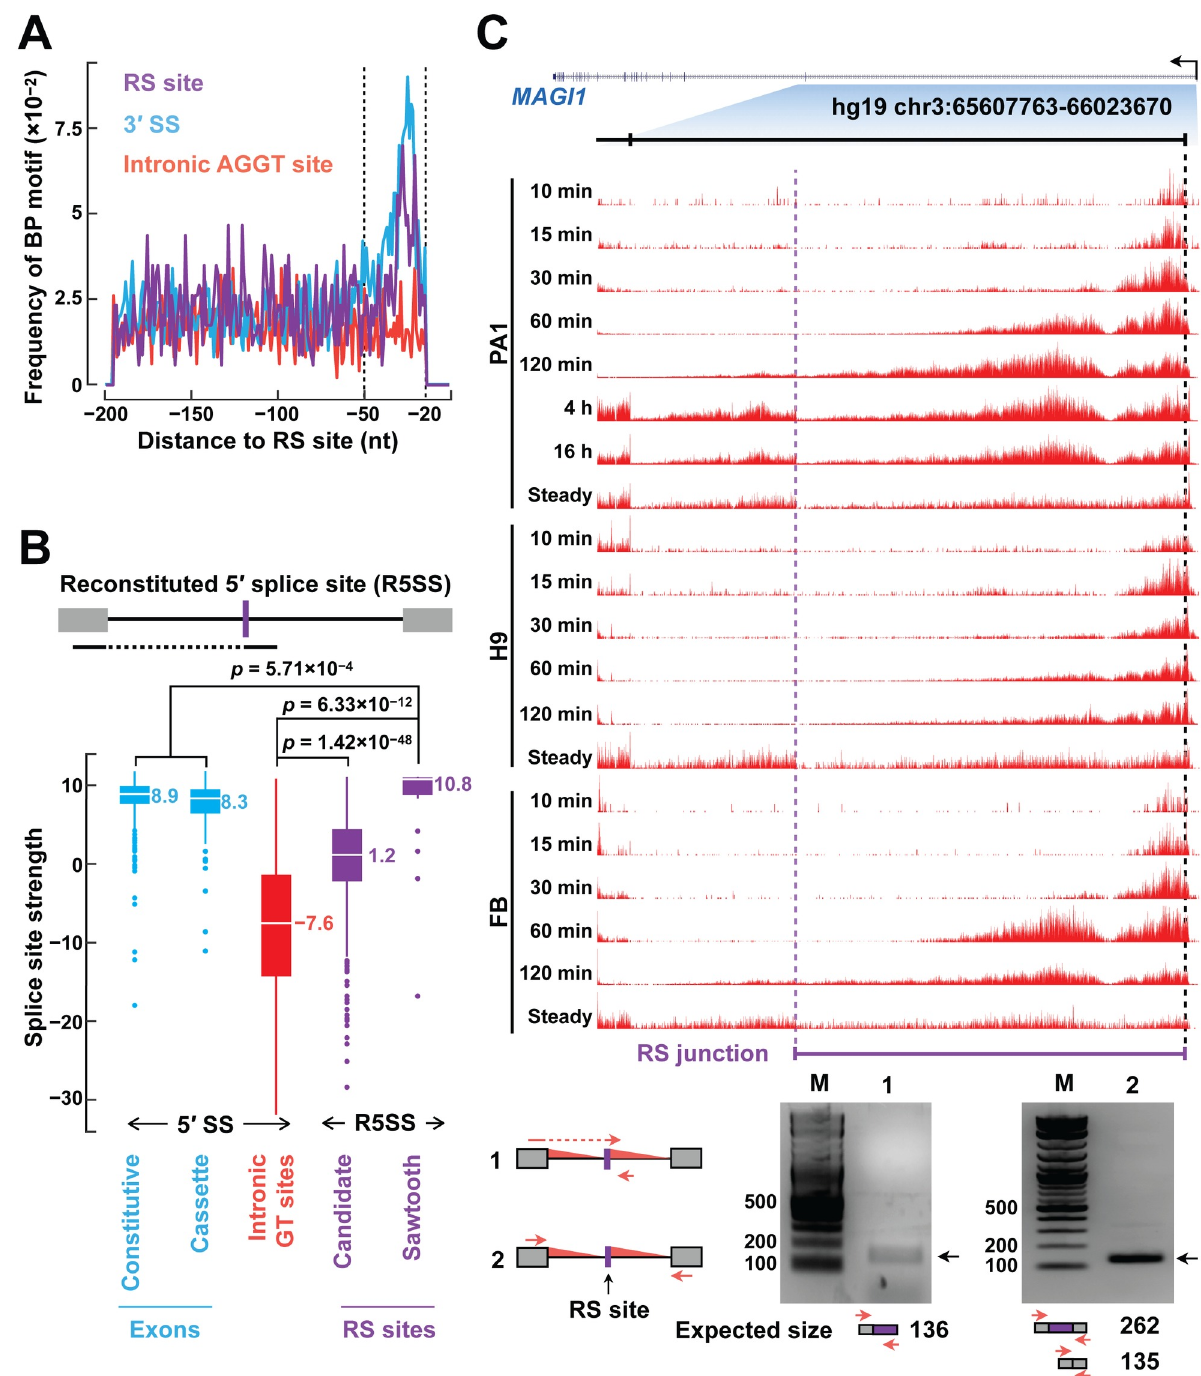
Fig 2. Validation of identified RS sites. (A) The branch-point motif is enriched in the 20–50 bp window upstream of RS sites (purple line) and canonical 3 0 splice sites (blue line), but not randomly sampled intronic AGGT sites (red line). (B) RS sites reconstitute strong 5 0 splice sites. The 5 0 splice sites reconstituted from RS sites are significantly stronger than randomly sampled intronic GT sites. The 5 0 splice sites reconstituted from sawtooth RS sites are even stronger than the 5 0 splice sites of cassette exons and constitutive exons. Median splice site strengths and Wilcoxon rank- sum test p -values are indicated. (C) We validated a novel RS site by RT-PCR. Top, 4sUDRB-seq signal tracks show the sawtooth pattern for an RS site in the first intron of the MAGI1 gene. Bottom, RT-PCR validation of the RS site. This recursive splicing junction was detected with recursive splicing specific primers (lane 1), but not with the primers that mapped to the exons (lane 2). PCR primers are indicated as red arrows in the figure and their sequences are provided in S6 Table.